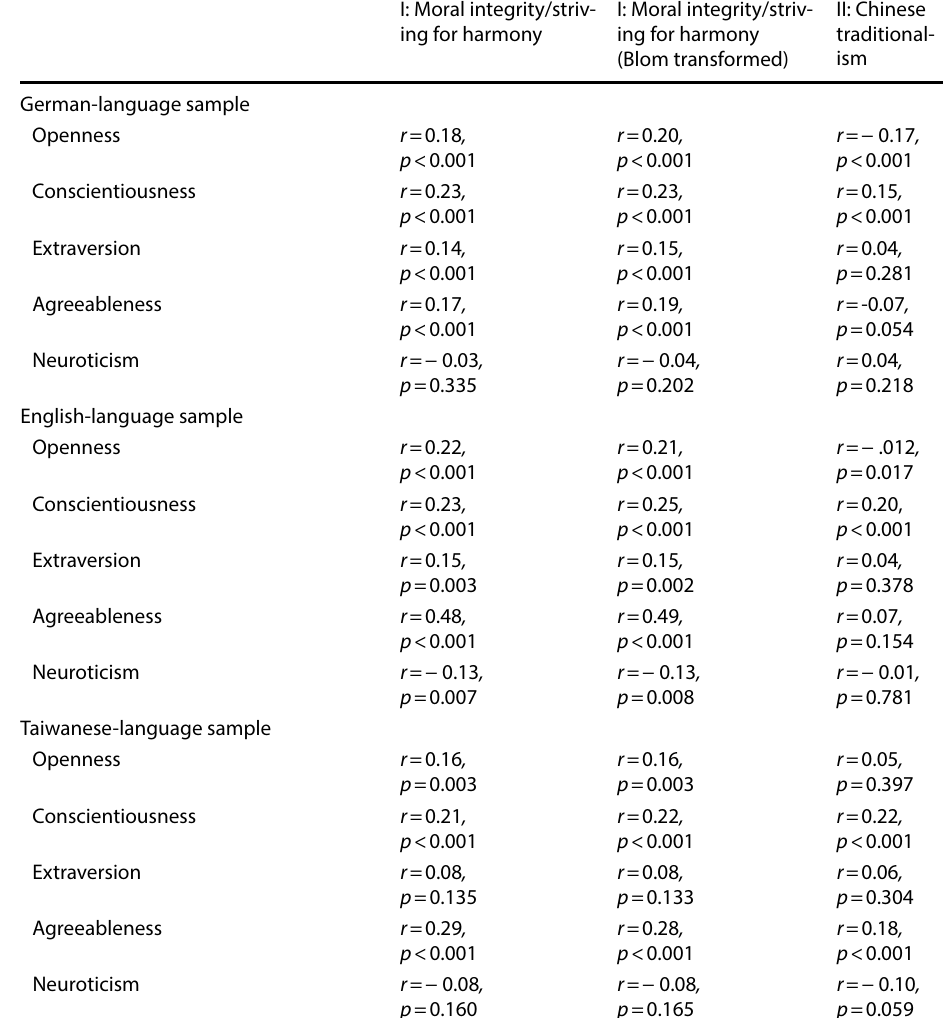
Table 4 Zero-order bivariate Pearson correlations between Big Five Inventory and the Chinese Value Survey